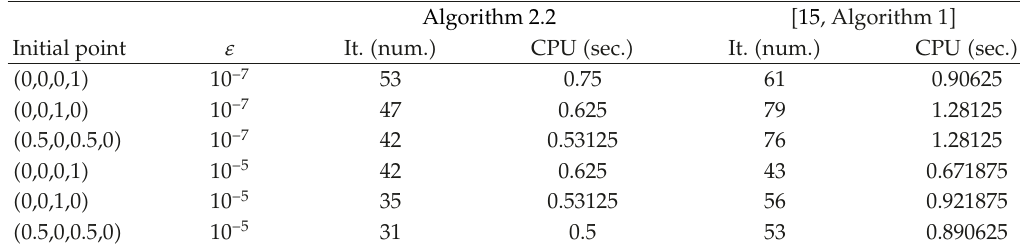
Table 2: Example 4.2. Algorithm